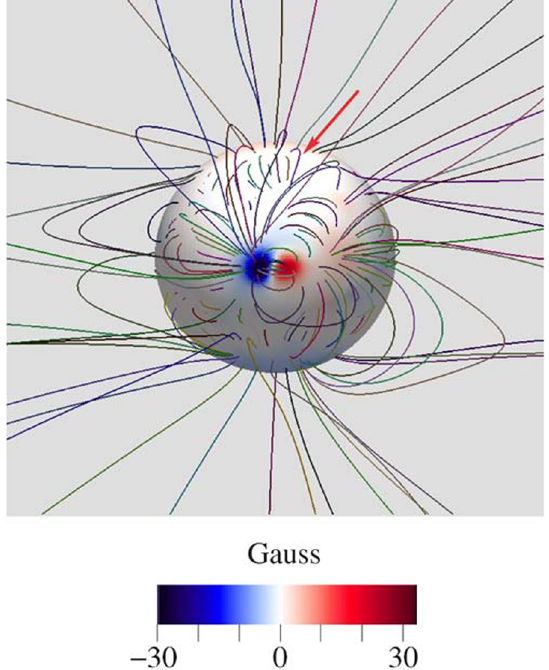
Fig. 16 Magnetic field model for the Sun around the time of Whole Sun Month (Carrington Rotation 1913, 1996 August 22 to September 18). The simulation was carried out with the thermodynamic model described in Sect. 4.5. The magnetic flux distribution was projected on the solar surface with selected magnetic field lines from the MHD solution. Image reproduced with permission from Lionello et